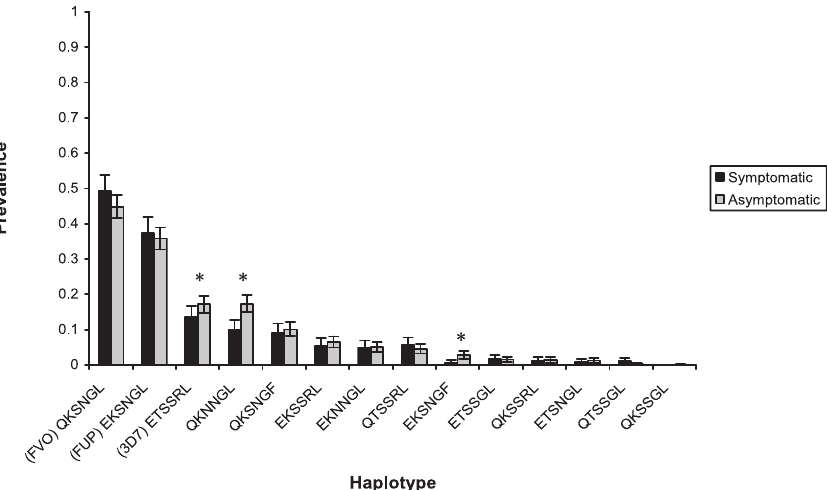
Figure 5. Prevalence of MSP-1 19 Haplotypes among Symptomatic and Asymptomatic Infections Bars indicate 95% CIs. *Chi-square p -value ¼ 0.08 (ETSSRL [3D7]), p , 0.001 (QKNNGL), and p ¼ 0.006 (EKSNGF). doi:10.1371/journal.pmed.0040093.g005 PLoS Medicine |